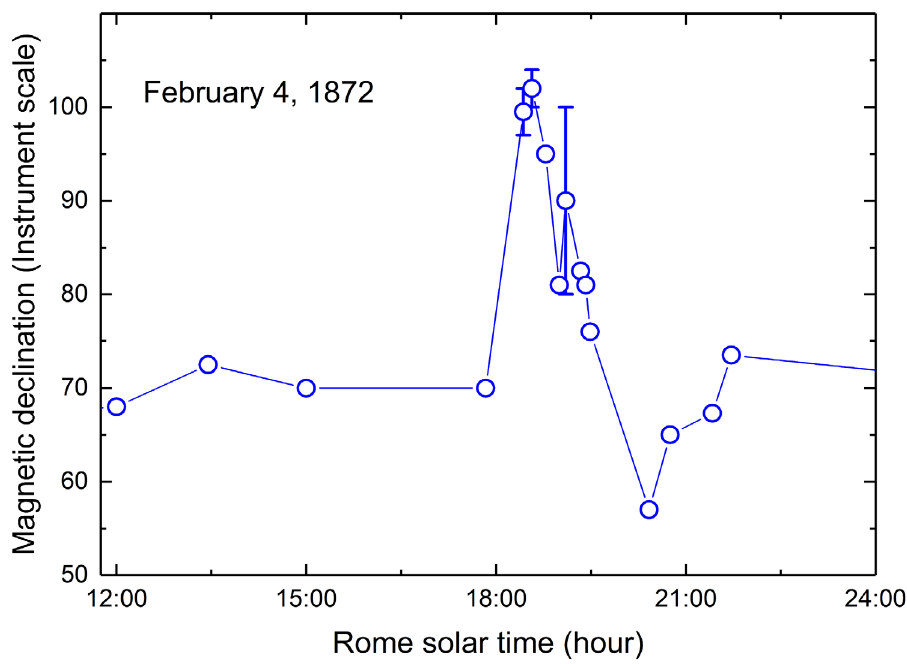
Fig. 4. The variations of the declination were recorded at the laboratories of the Roman College on 4 February 1872 and reported in